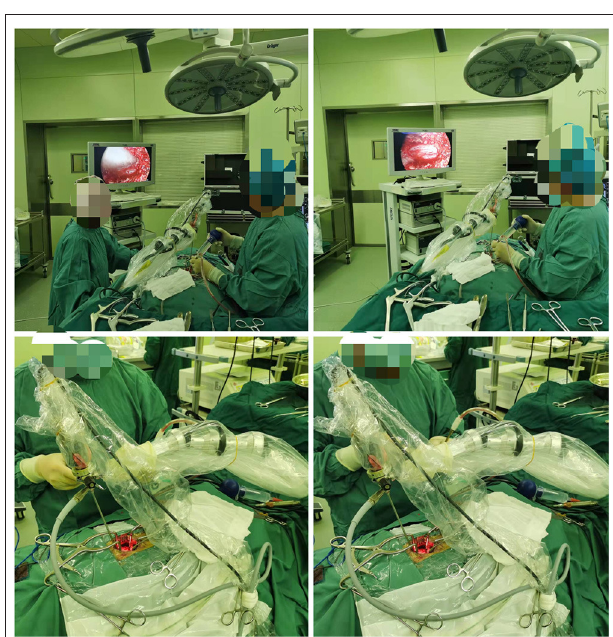
FIGURE 2 | Describe the location of intraoperative